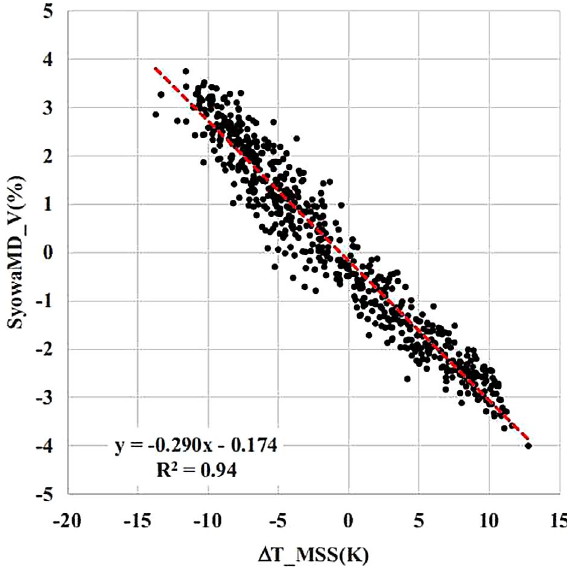
Fig. 9. A scatter plot between D T MSS and the pressure corrected daily mean count rate in Syowa MD vertical channel